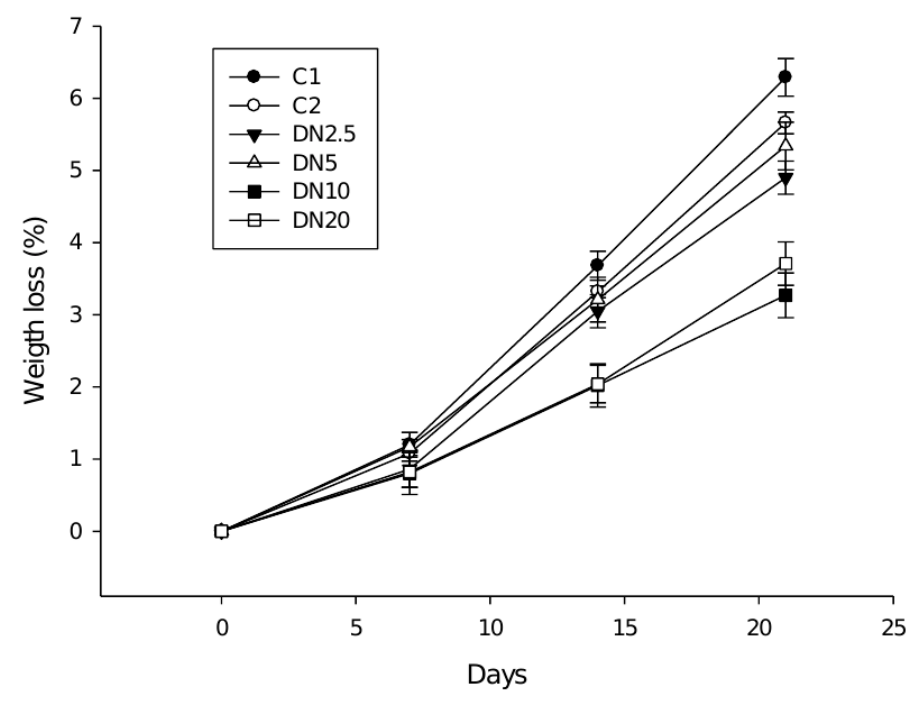
Figure 1. Percentage of weight loss in tomato fruits coated with nanoemulsion during storage at 6 °C.